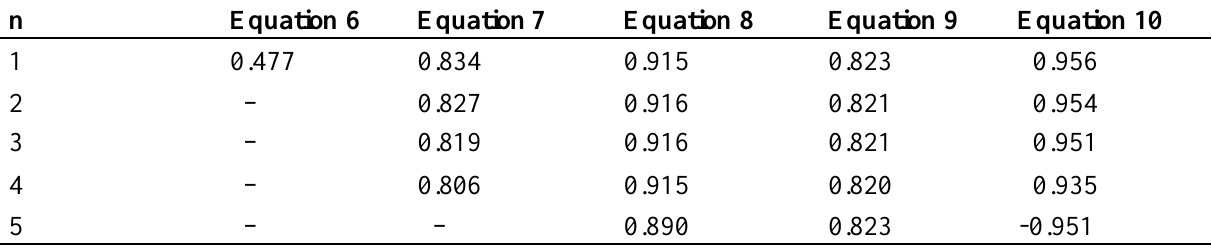
Table 3. Cross-validation correlation coefficient in a leave- n- out procedure for a homologous series of phenyl